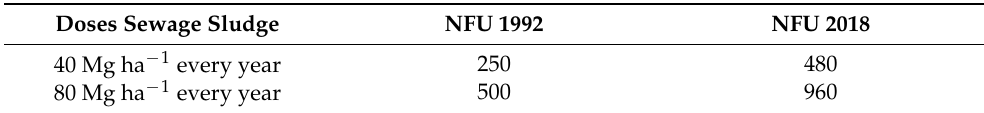
Table 2. N fertilizer units (NFU) provided by the study doses according to the N concentration in SS as used at the beginning of the study (1992), and at the end of the study (2018), without taking into account the annual yield of N for the dose